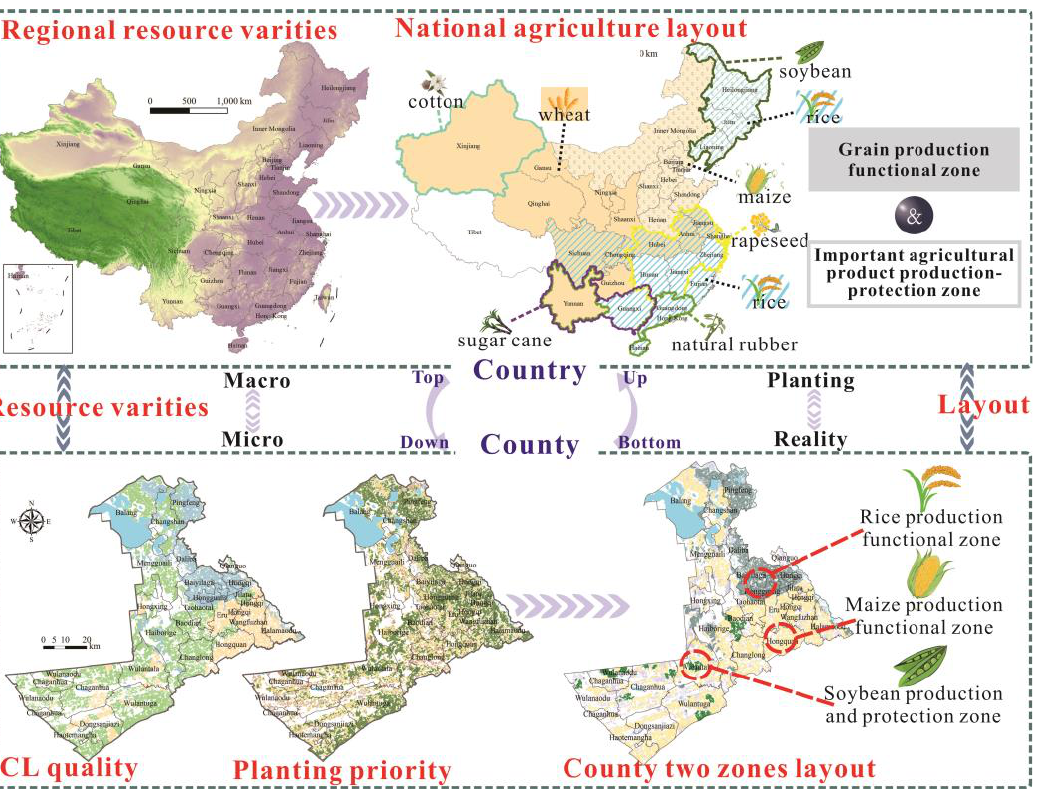
Figure 11. Two zones policy from county to country.